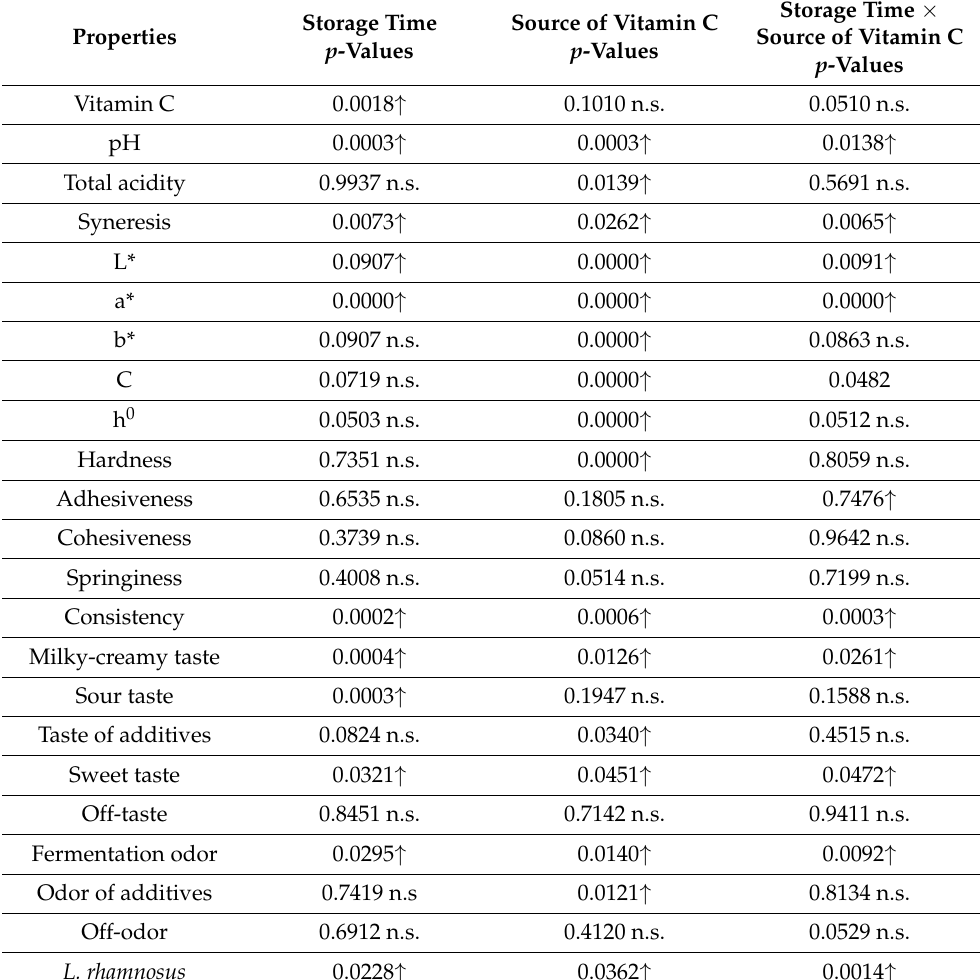
Table 2. Analysis of variance (ANOVA) p -values on the effects of storage time and the source of vitamin C addition on vitamin C, pH, total acidity, syneresis, color parameters: L*, a*, b*, C, h 0 , hardness, adhesiveness, stringiness length, cohesiveness, springiness, preference, consistency, milky- creamy taste, sour taste, taste of additives, sweet taste, off taste, sour odor, odor of additives, off odor, L. rhamnosus of fermented